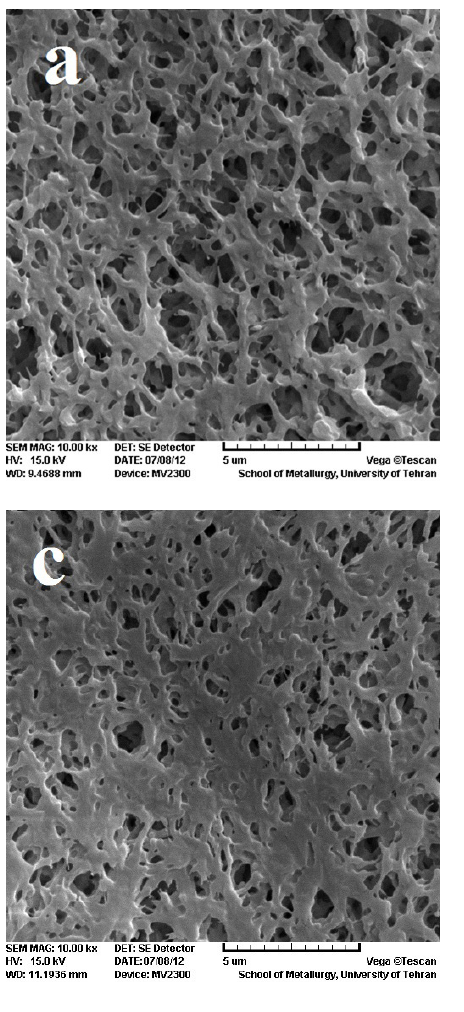
Figure 2. Scanning electron microscopy (SEM) image of PVDF membrane. ( a ) reference; ( b ) 100 kGy; ( c ) 150 kGy; ( d ) 300